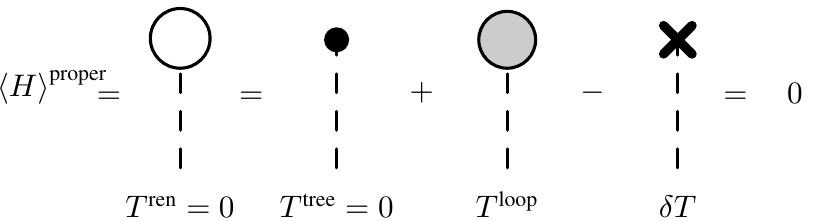
Figure 2 . Renormalization condition in the standard tadpole scheme: the requirement of the renormalized tadpole graph (white blob) to vanish together with the tree-level tadpole being zero (cid:12)xes the tadpole